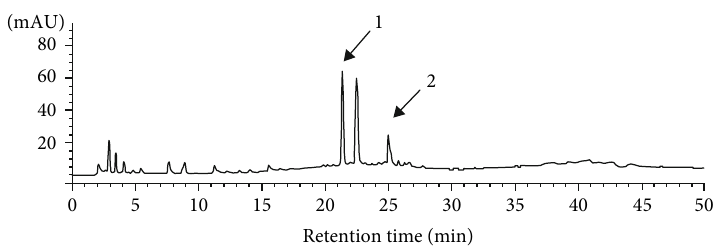
Figure 1: HPLC chromatograms of H. zeylanica water (HZW) extract. 1: quercetin-3- O- β -D-glucopyranosyl-4 ′ - O - β -D-glucopyranosyl- (1 → 2)- β -D-glucopyranoside; 2: quercetin-4 ′ - O - β -D-glucopyranosyl-(1 → 2)- β